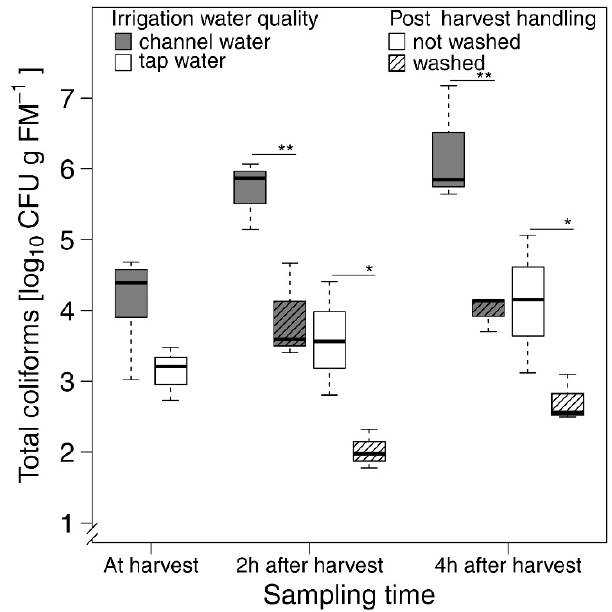
Figure 3. Experiment to evaluate the effect of irrigation water source (channel and tap water) and post-harvest washing on the total coliform load of lettuce cultivated in an urban production farm in Ouagadougou (Burkina Faso) in 2014. Stars indicate significant differences between the mean of washed and unwashed samples using p < 0.01 (*) and p < 0.001 (**) as significance thresholds. Boxplots show the lower, median, and upper quartile, with whiskers extending to the most extreme data point that is no more than 1.5 times the interquartile range from the edge of the